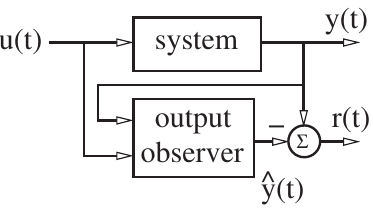
Figure 1. Fault detection